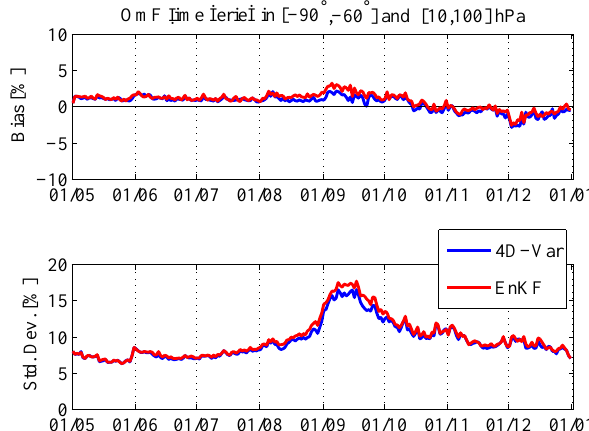
Figure 5. Observations-minus-forecast time series, bias (top row) and standard deviation (bottom row), for the EnKF (red lines) and the 4D-Var (blue lines) with respect to the assimilated EOS Aura-MLS data between 1 and 10hPa and between − 90 and − 60 ◦ for the period May–December 2008.